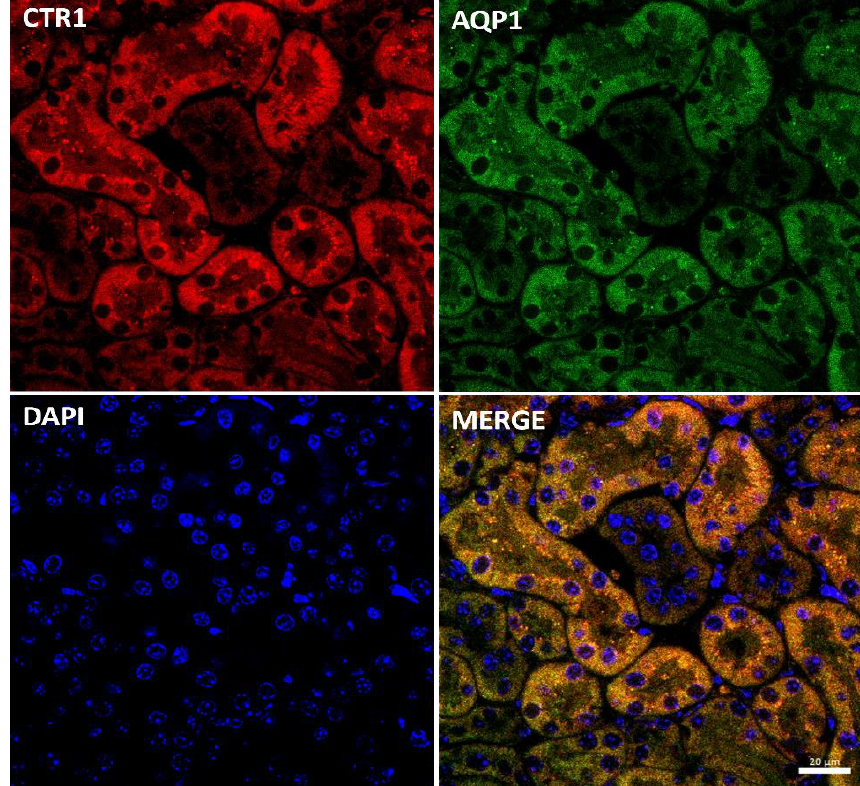
Figure 2. Co-localization of CTR1 (red channel) and aquaporin1 (AQP1, green channel), a proximal tubule marker in the kidneys of 14-day-old w-t mouse analyzed by confocal microscopy. Nuclei were counterstained with DAPI. Bar corresponds to 20 μm.